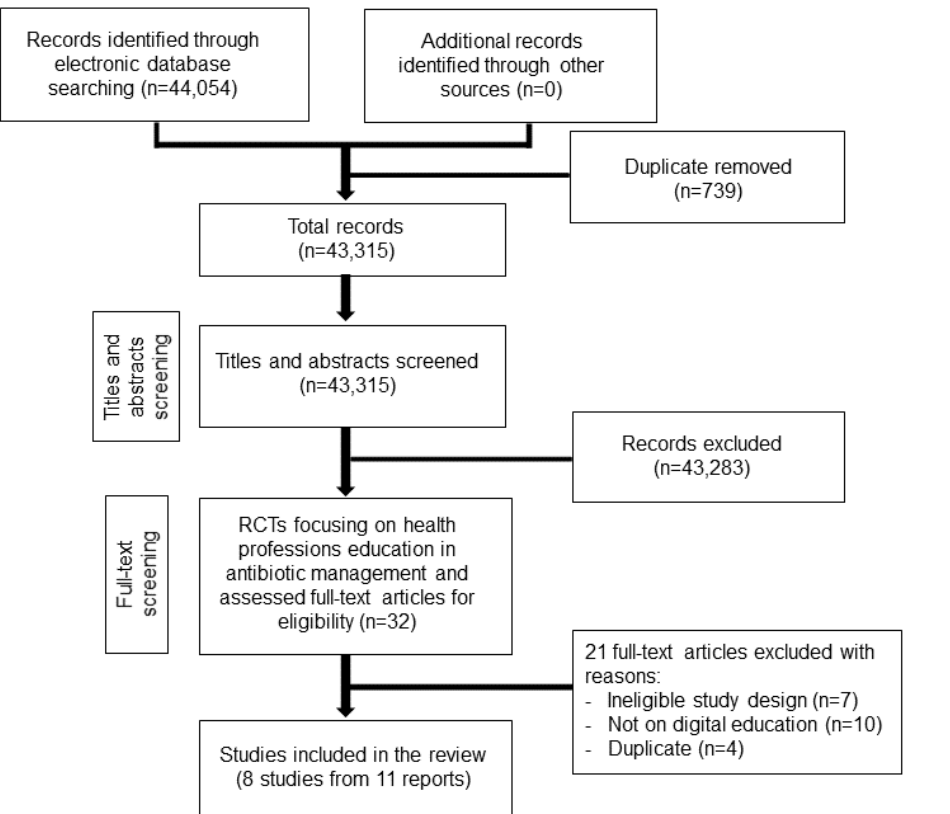
Figure 2. Study selection process. RCT: randomized controlled